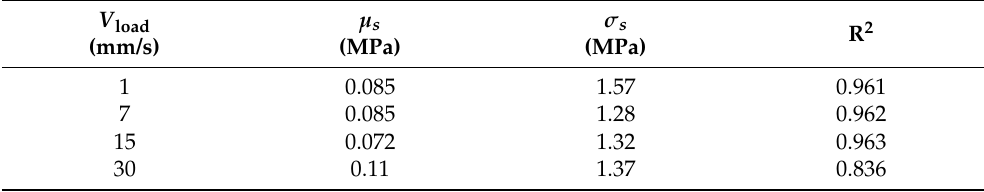
Figure 9. Local pressure versus probability. ( a ) V load is 1 mm/s; ( b ) V load is 7 mm/s; ( c ) V load is 15 mm/s; ( d ) V load is 30 mm/s. Table 4. Parameters of the lognormal distribution at various